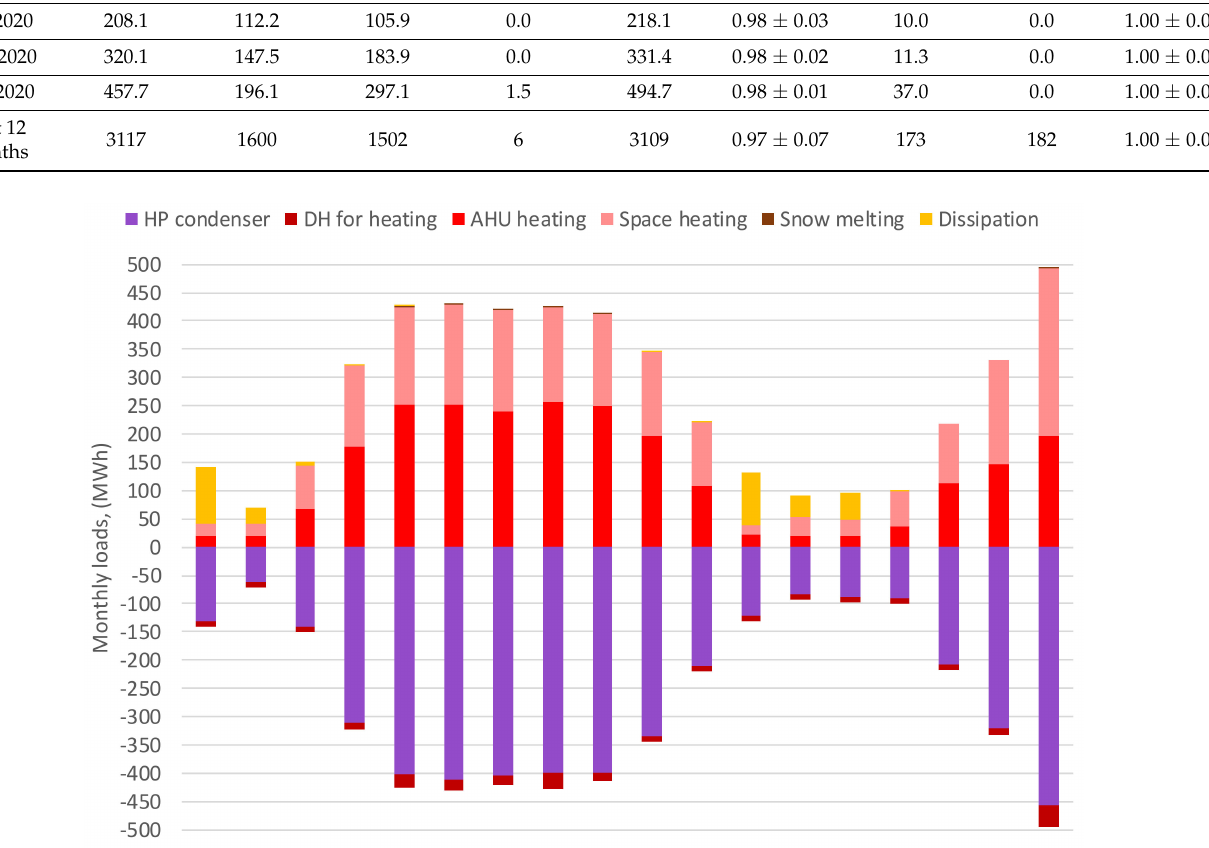
Figure 8. Monthly loads on the condenser